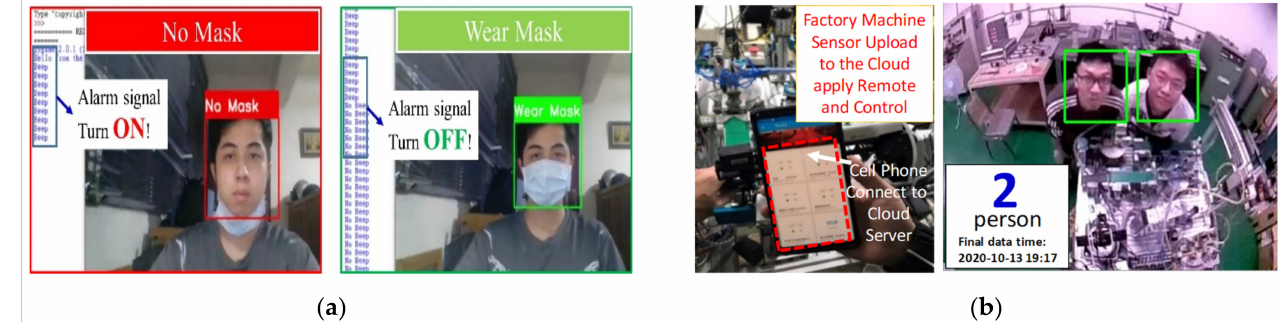
Figure 12. IoT PLC smart-factory-monitoring field platform: ( a ) physical layer sensing numerical platform, ( b ) detected signal upload to cloud